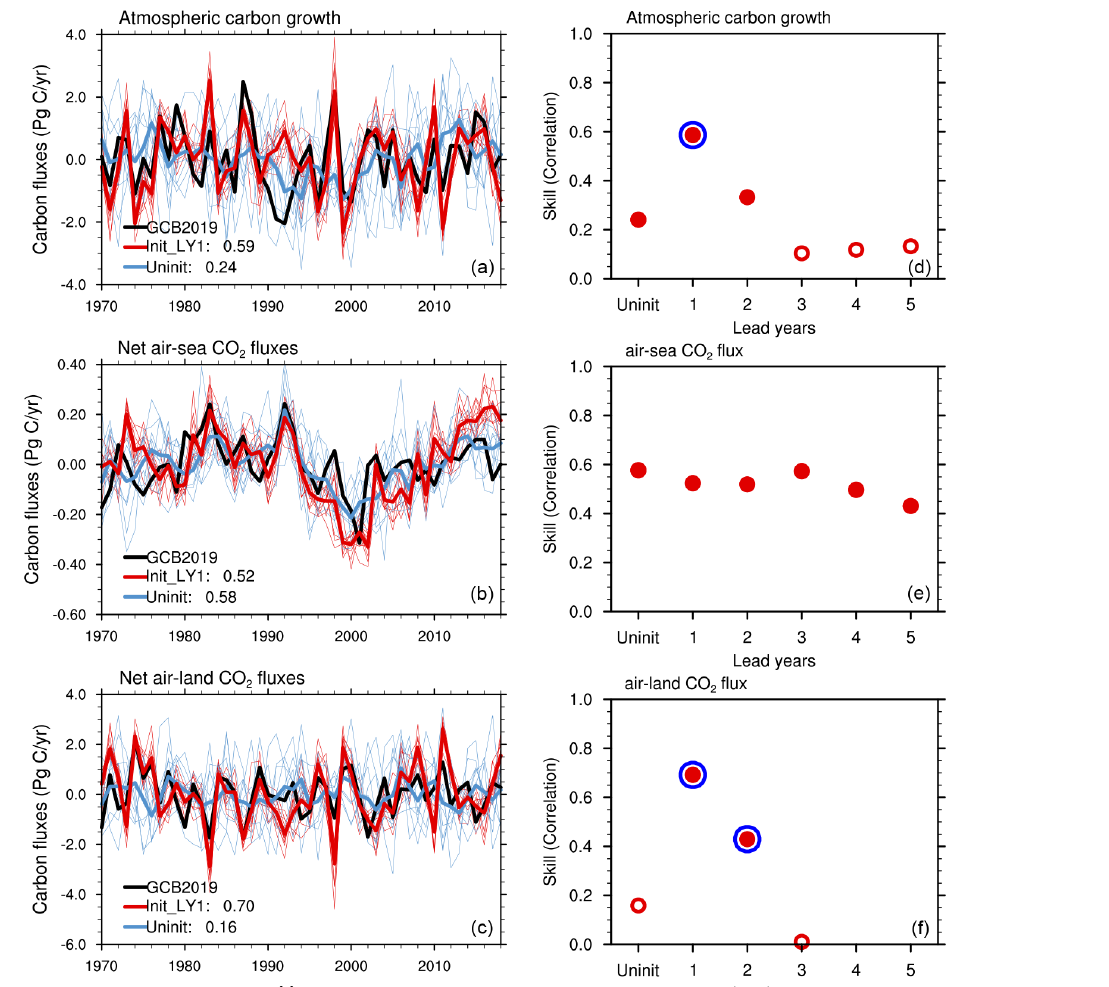
Figure 5. The same as Fig. 4 but with linearly detrended time